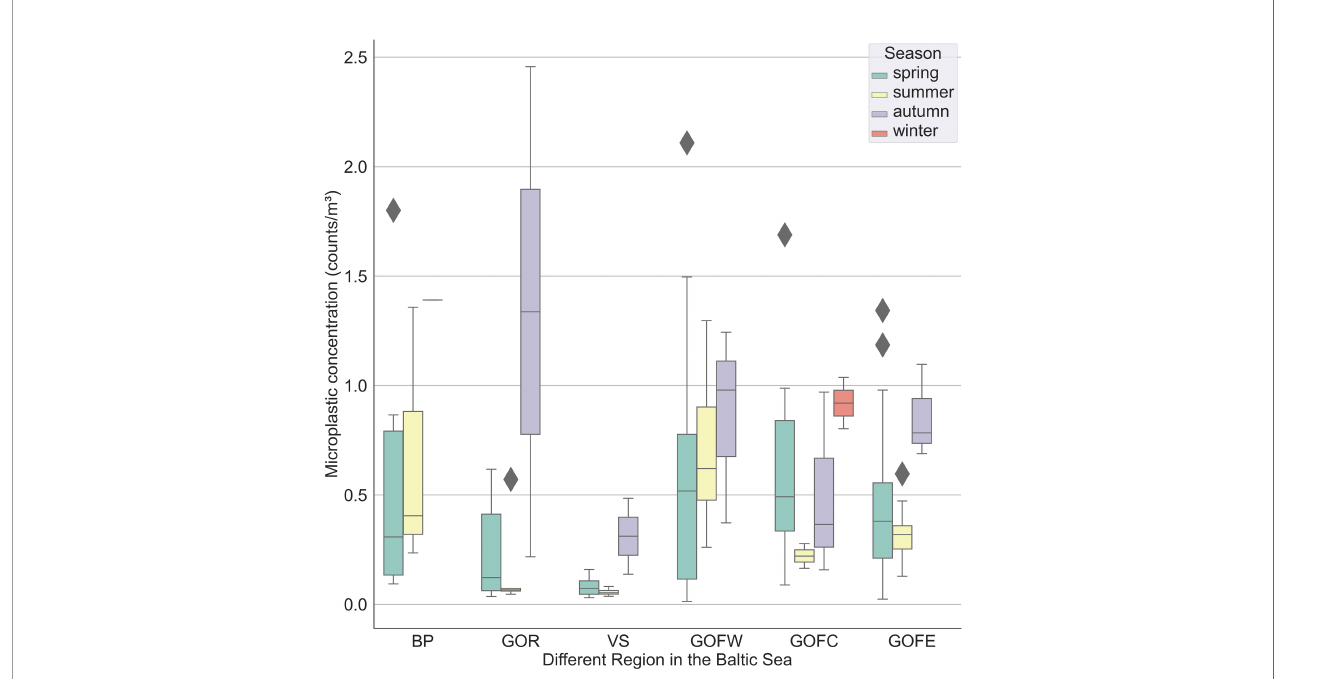
FIGURE 6 | Seasonal variability of MP concentration across different regions in the Baltic